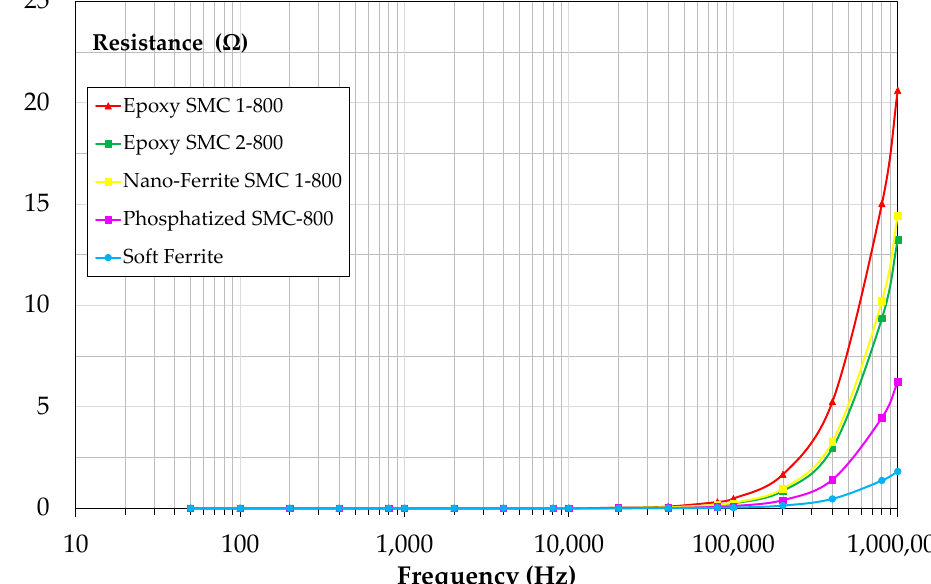
Figure 14. Resistance values of produced SMC and soft ferrite rod inductors in a frequency range up to 1 MHz.